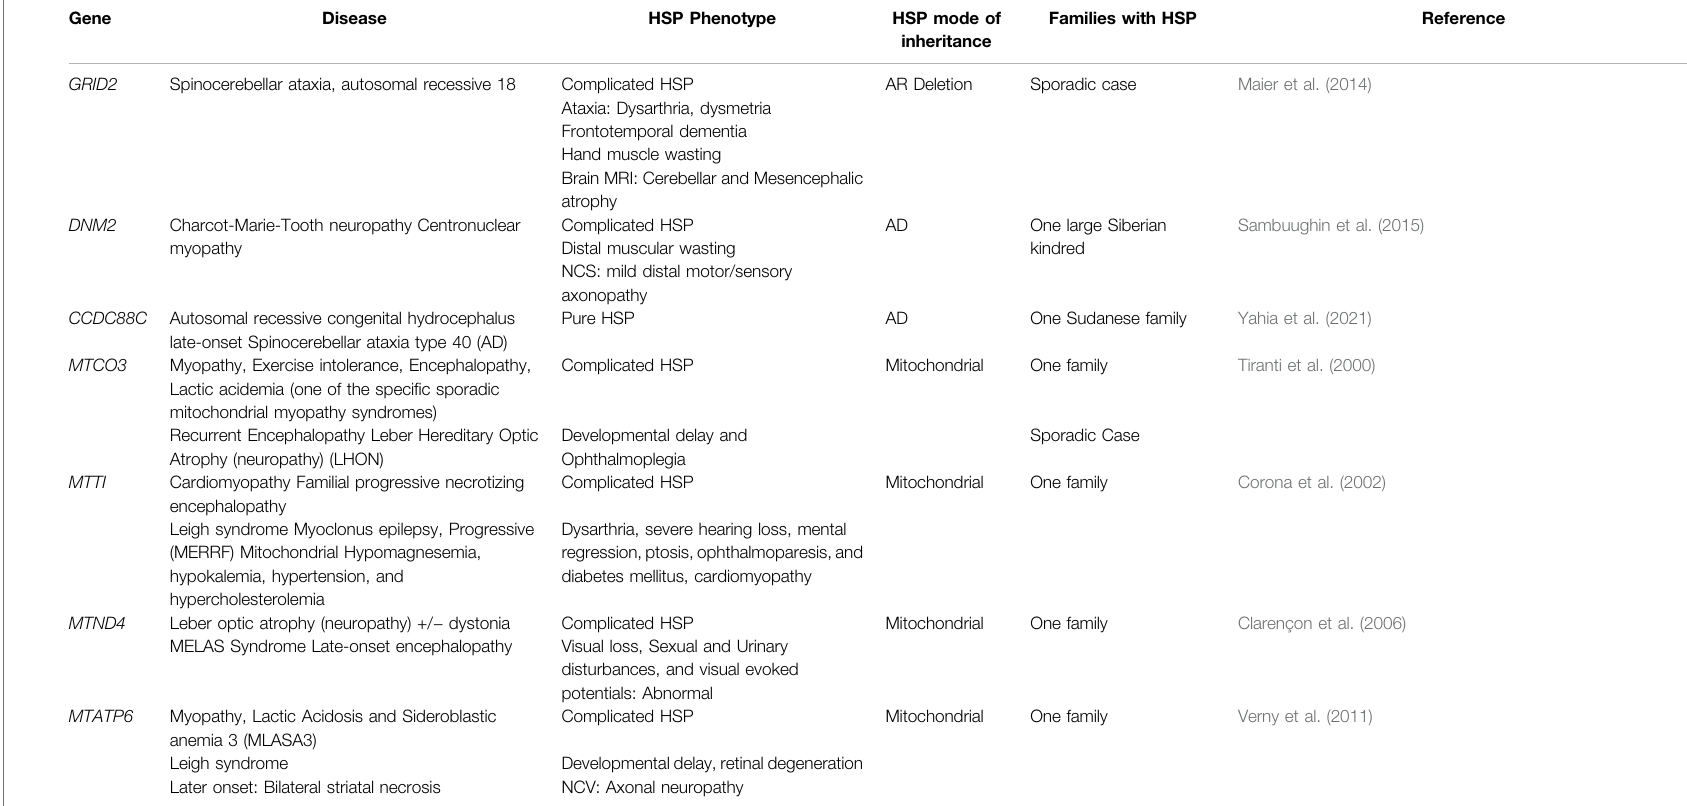
TABLE 1 | ( Continued ) Table summarizing HSP forms associated with non-SPG genes and the main allelic phenotypes associated with causative variants in these